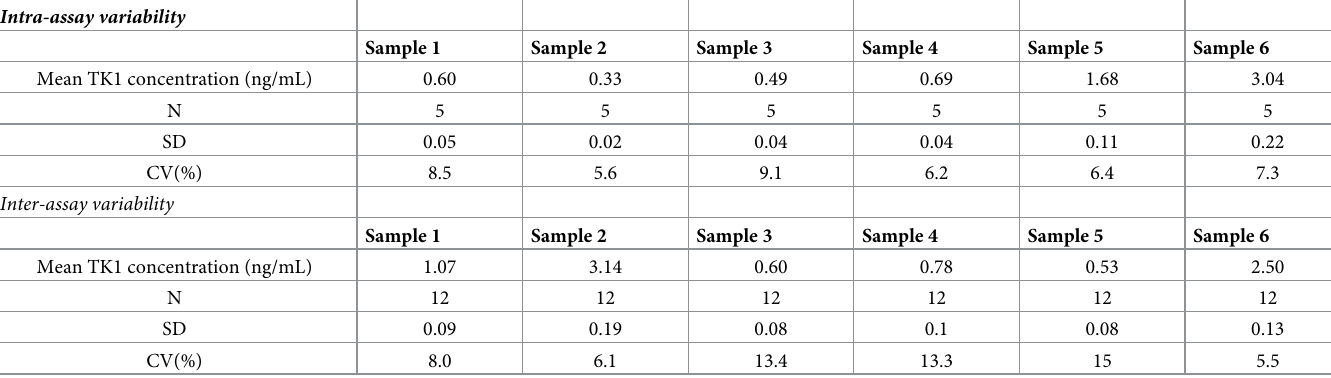
Table 2. Intra-and Inter assay variability of serum samples with AroCell TK 210 ELISA.